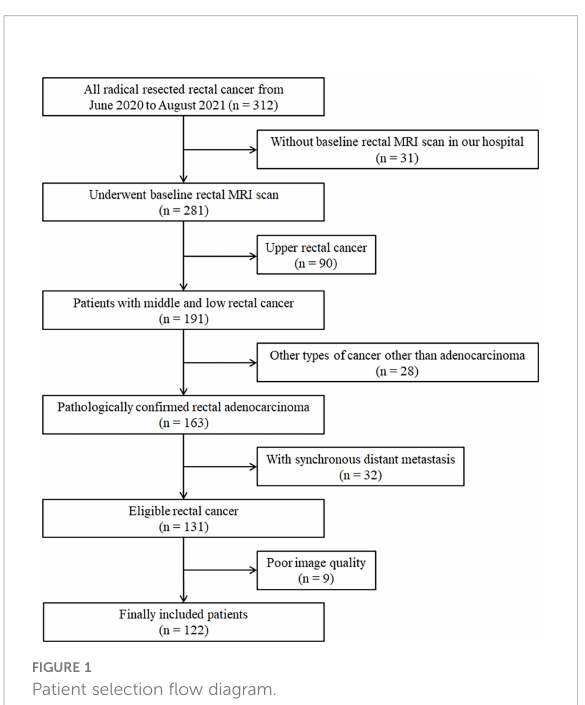
FIGURE 1 Patient selection fl ow